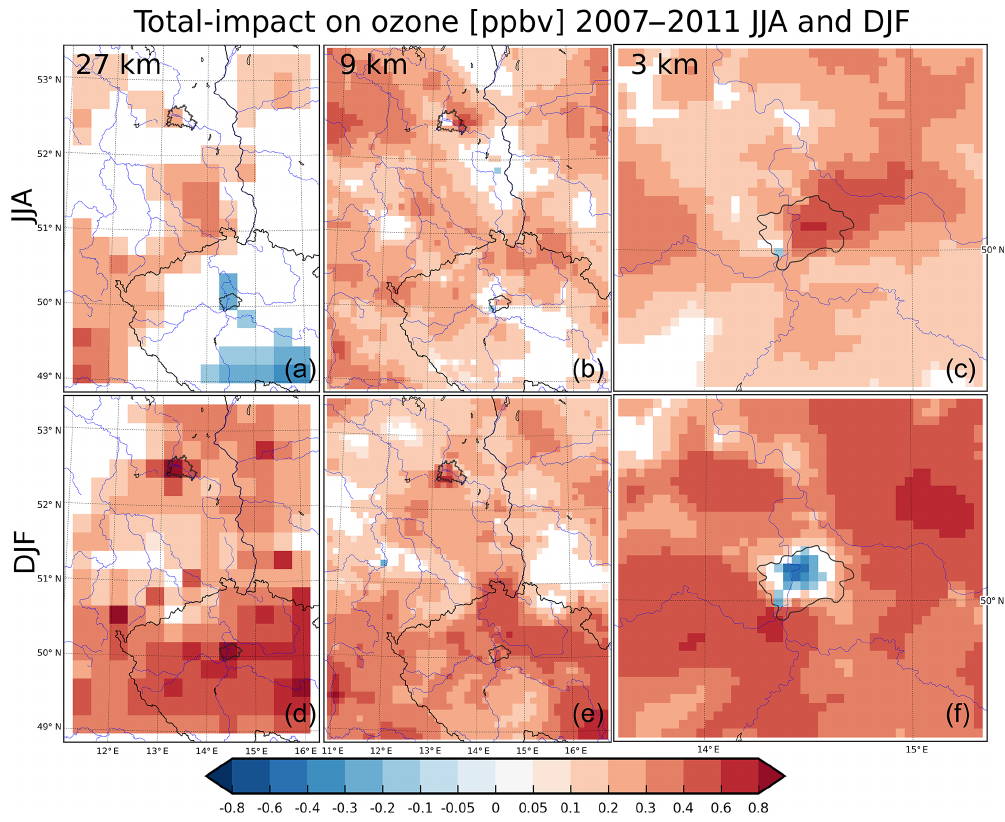
Figure 28. The total impact of urban meteorological changes (i.e., temperature, humidity, wind and vertical eddy diffusivity) on surface O 3 concentrations in ppbv for the 27, 9 and 3km resolutions (left to right) for JJA (a, b, c) and DJF (d, e, f) . Shaded areas represent statistically significant changes on the 98% threshold level using a two-tailed t test. The default CMAQ K v method was invoked in this calculation. The geographic locations of Berlin and Prague are indicated by their administrative